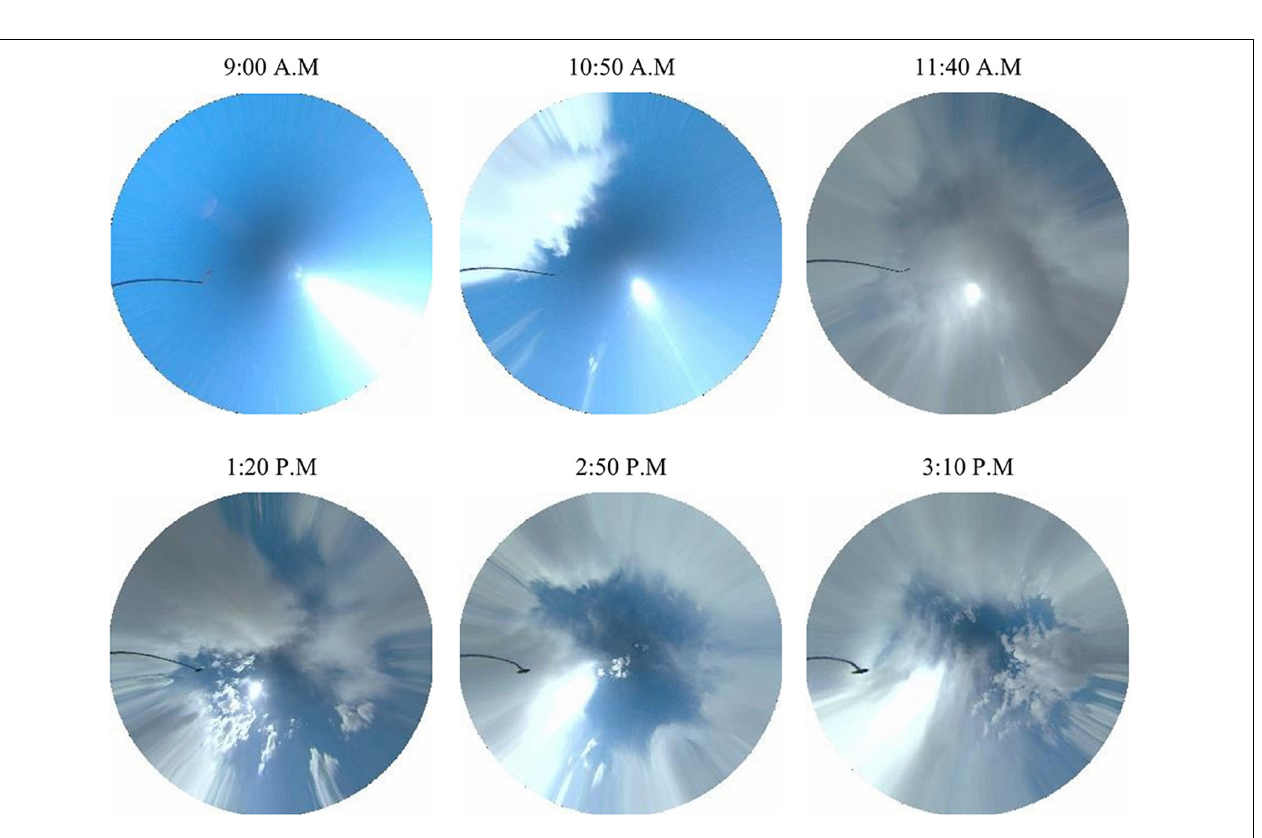
FIGURE 8 | Cloud cover images on February 28,